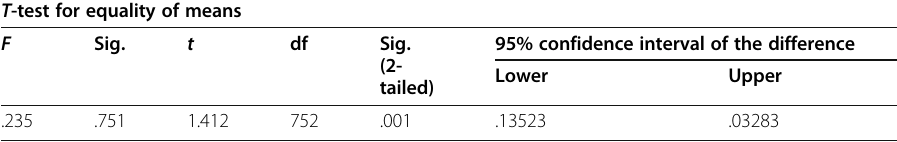
95% confidence interval of the difference (2- Lower Upper tailed)